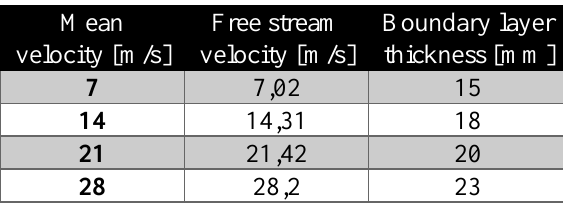
Fig 7. Velocity profile, mean velocity of 7 m/s .